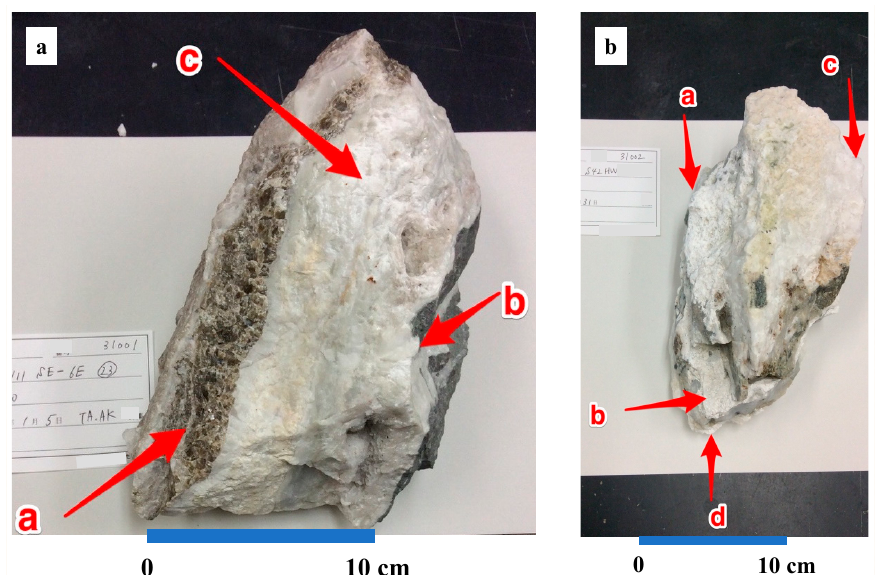
Figure 3. Photos of representative vein samples. ( a ) Sample 31001 with the analysis localities a, b,